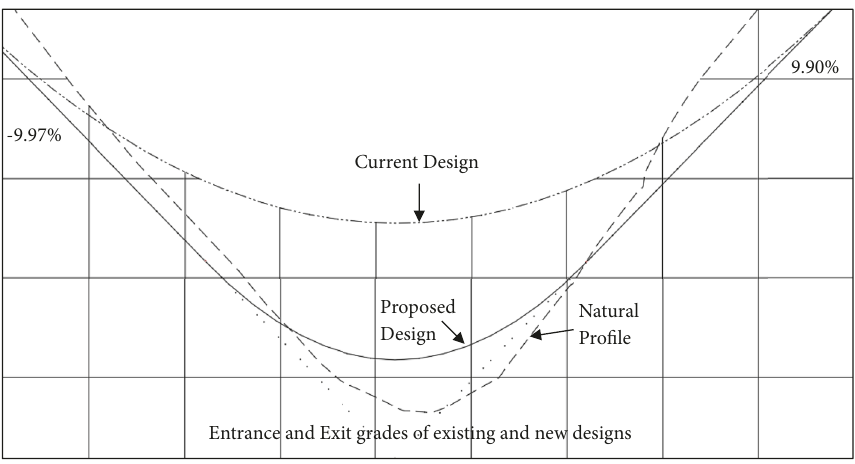
Figure 6: AutoCAD schematic of sag vertical curve #4 of Table 3: current, proposed, and natural profiles. Table 3: Comparing lengths of vertical curves of current and proposed